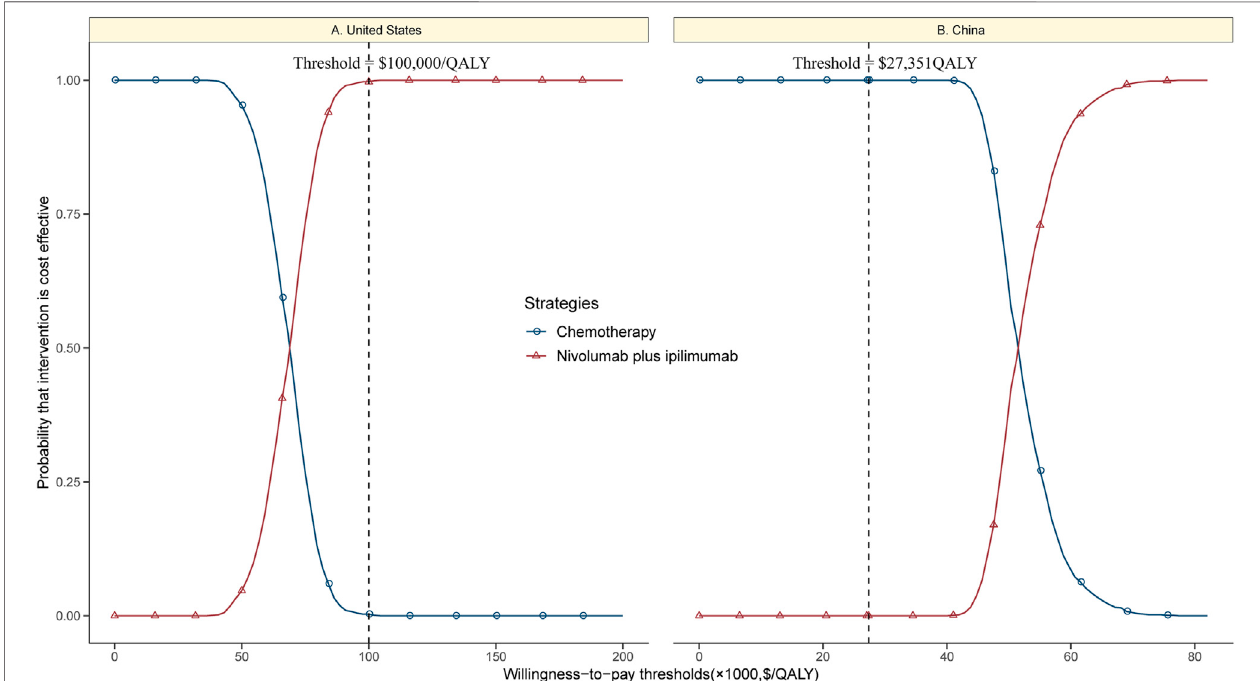
FIGURE 4 | Cost-effectiveness acceptability curves of nivolumab plus ipilimumab vs. chemotherapy in the United States (A) and China (B) .